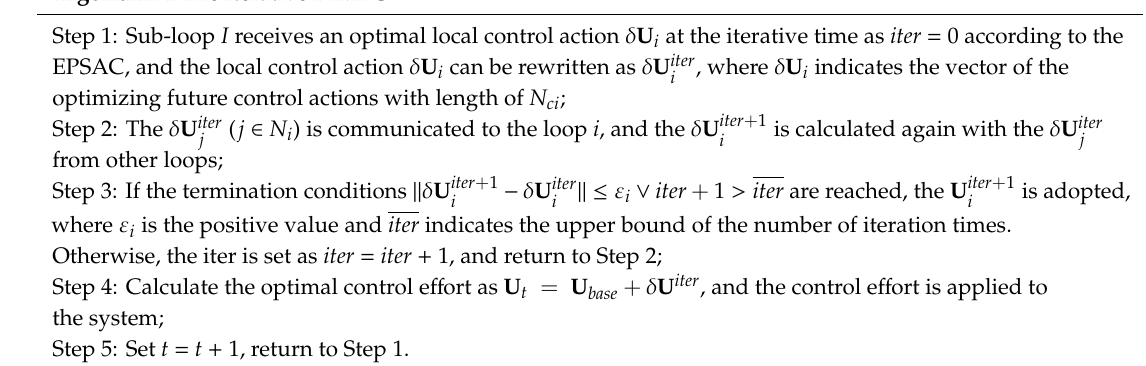
Algorithm 1 The Iterative DiMPC